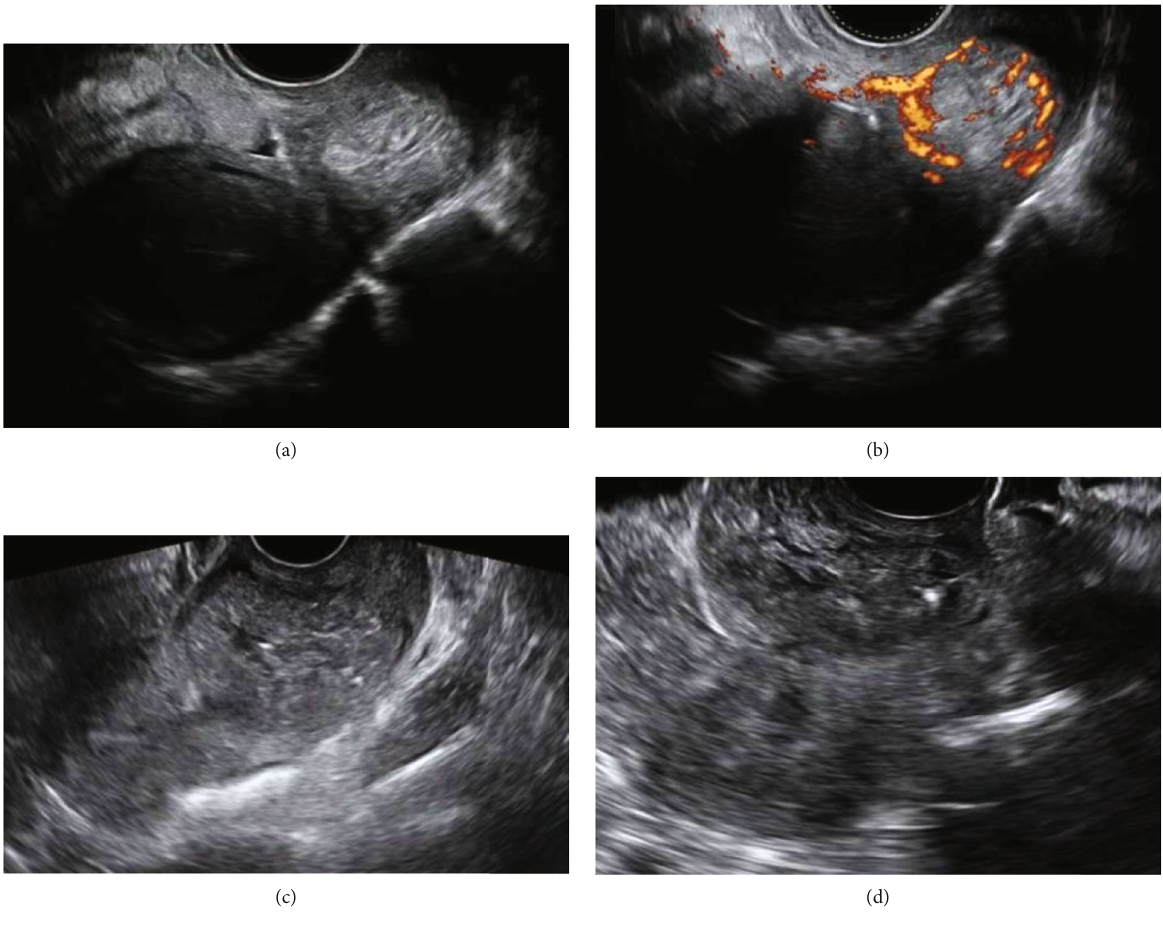
Figure 3: (a, b) 16 days posttreatment, β -hCG levels 3.689 mIU/mL, (c) 28 days posttreatment, β -hCG levels 305.7 mIU/mL, and (d) 31 days posttreatment, β -hCG levels 86.4 mIU/mL.